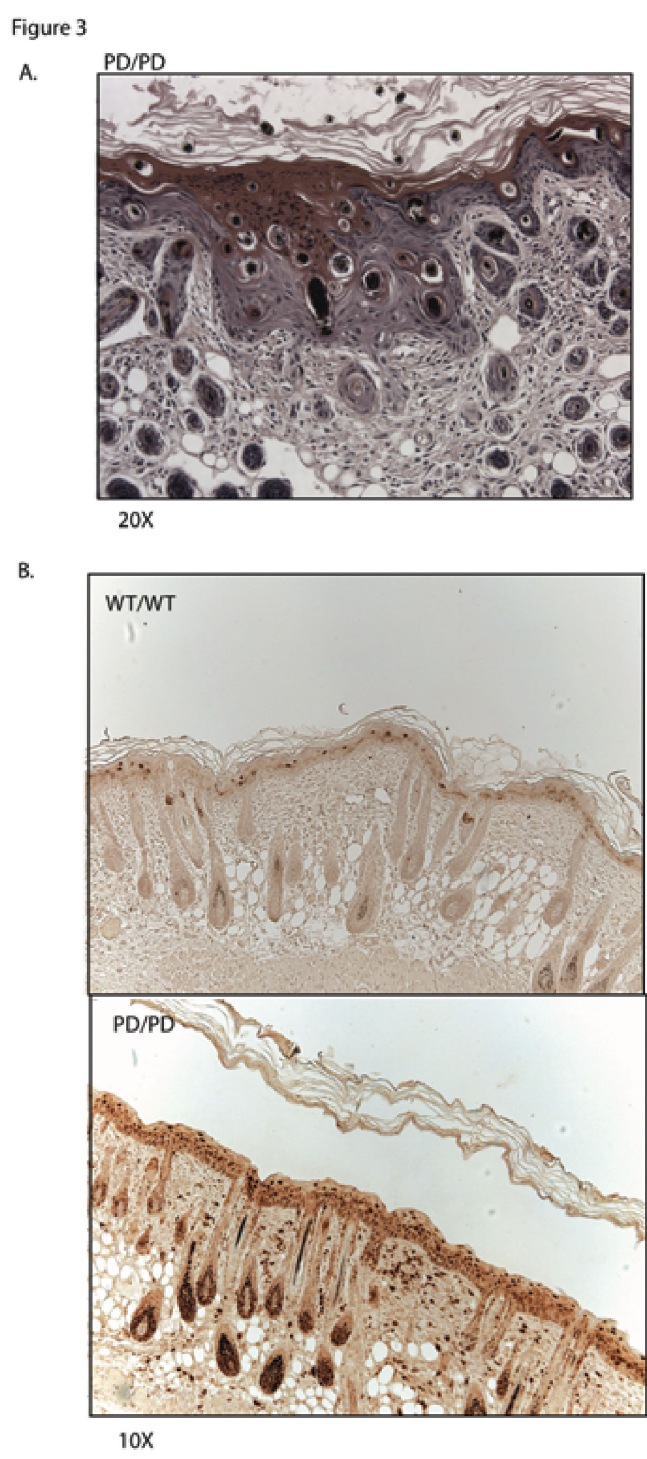
Figure 3. Proliferation and Dysplasia of PD mouse skin. A. Homozygous PD mouse skin at 10 days showing focus of epidermal dysplasia with aggregates of basaloid cells in the epidermis without penetration of the basement membrane. B. Examination of proliferation of epidermal keratinocytes in mouse skin with Ki-67. Nuclear Ki-67 is restricted to the basal keratinocytes in wild-type littermate controls (top) whereas the PD homozygous mouse has positive staining at all levels of the epidermis (bottom). Skin treated with a rat isotype control shows no non-specific staining in the epidermis (not shown). doi: 10.1371/journal.pone.0071887.g003 PLOS ONE |